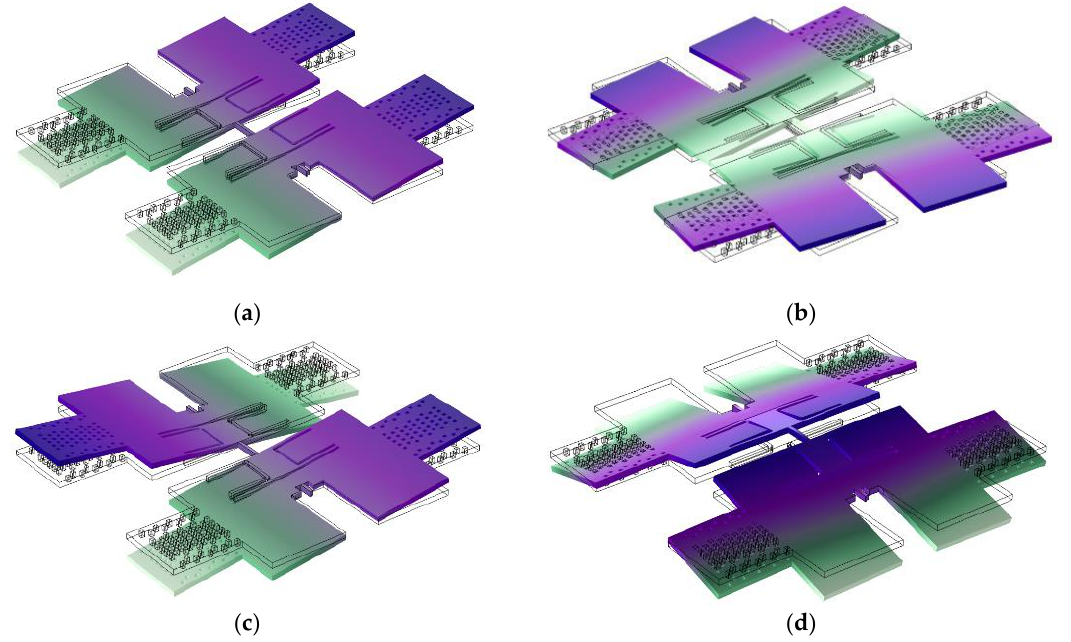
Figure 2. The modal simulated results of BFVG: ( a ) mode 1; ( b ) mode 2; ( c ) mode 3; ( d ) mode 4.